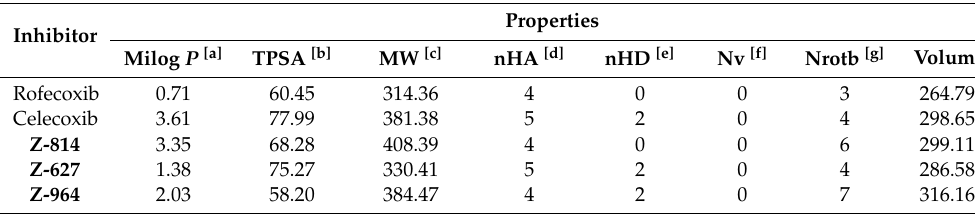
Table 12. Physicochemical data of the selected